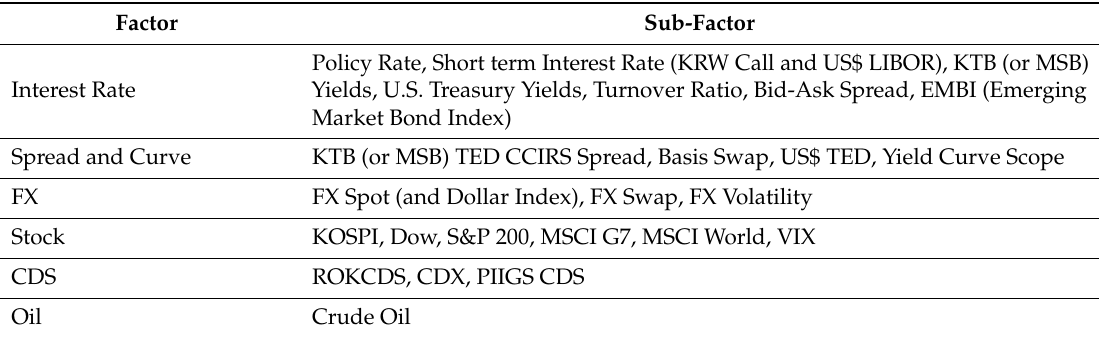
Table 2. Factors a ff ecting cross-border investment investigated in existing Table 2. Factors affecting cross-border investment investigated in existing literature.